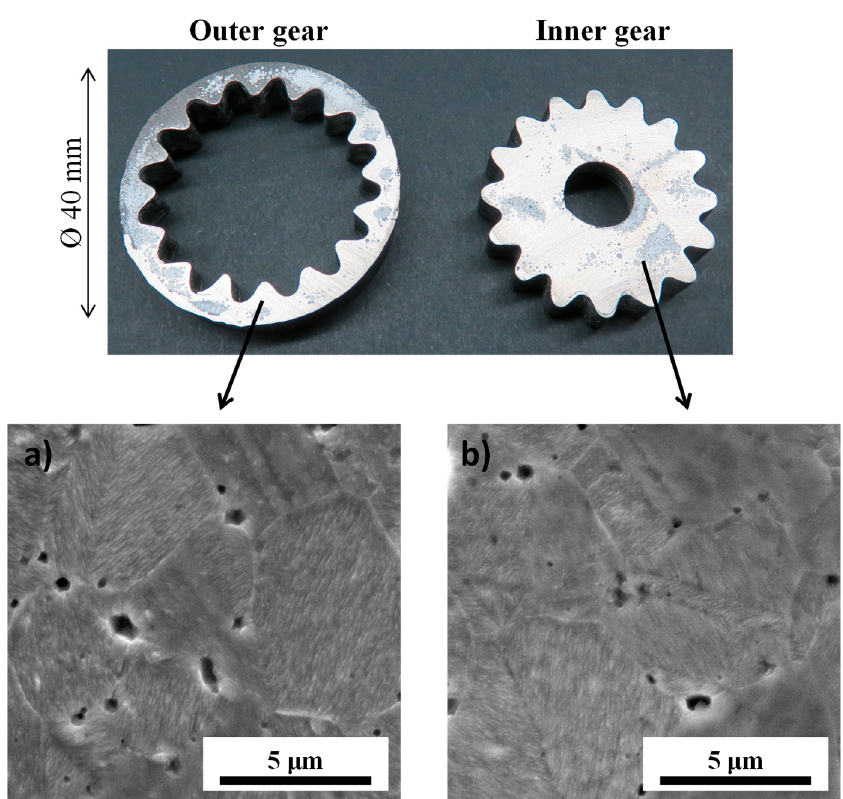
Figure 7. Polished and etched SEM microstructure for the ( a ) outer gear (edge of the SPS specimen) and ( b ) the inner gear (center of the SPS